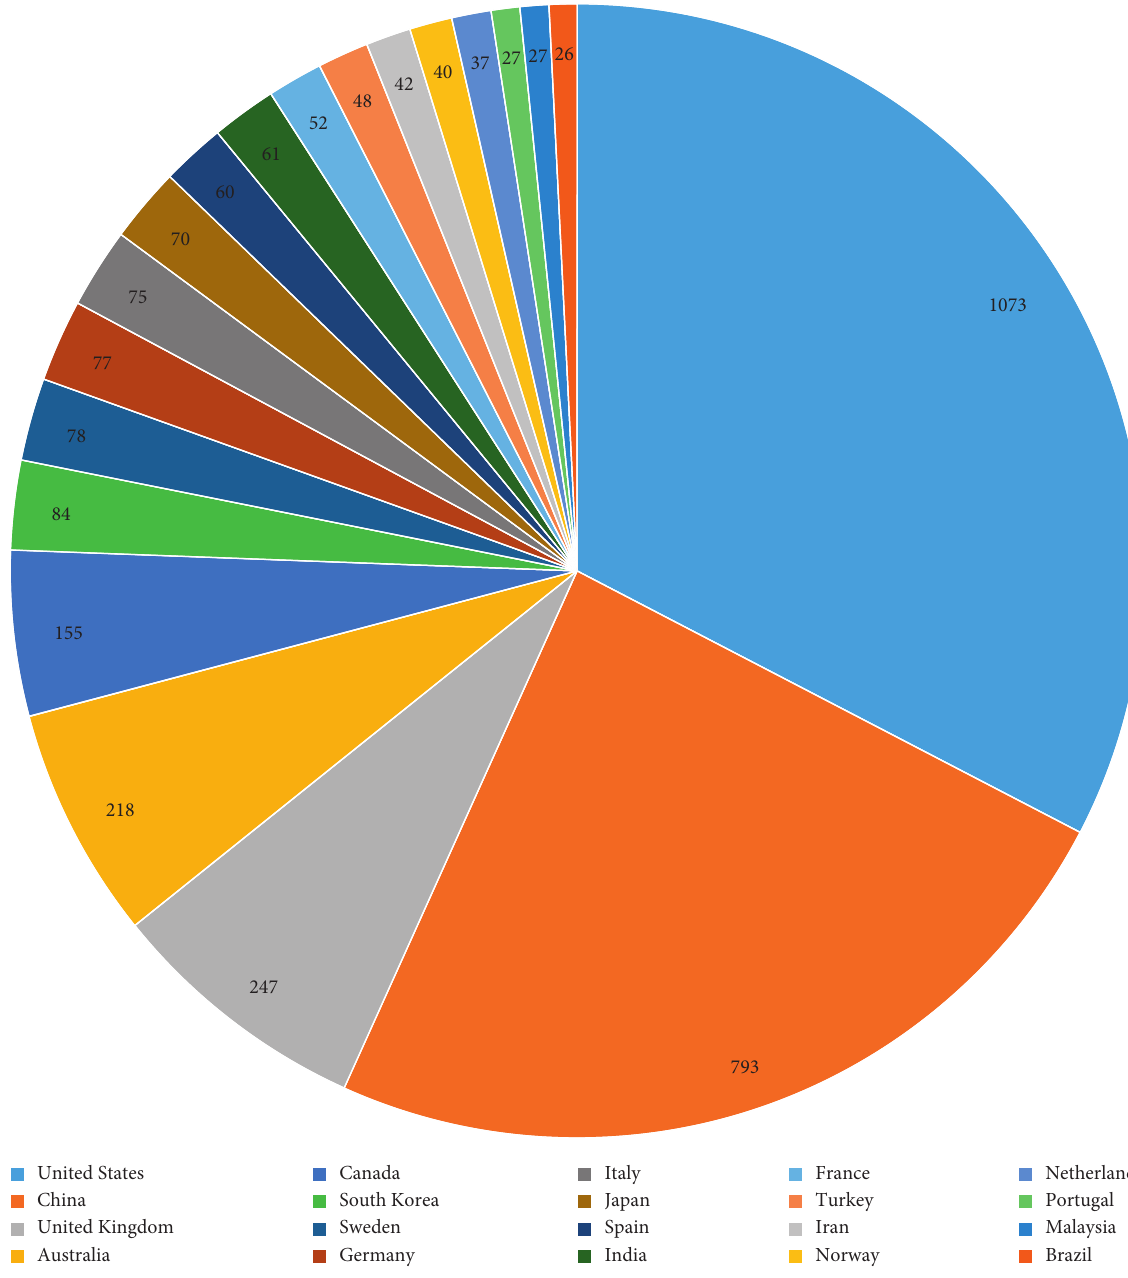
Figure 2: Distribution of academic achievements on roadside safety in different